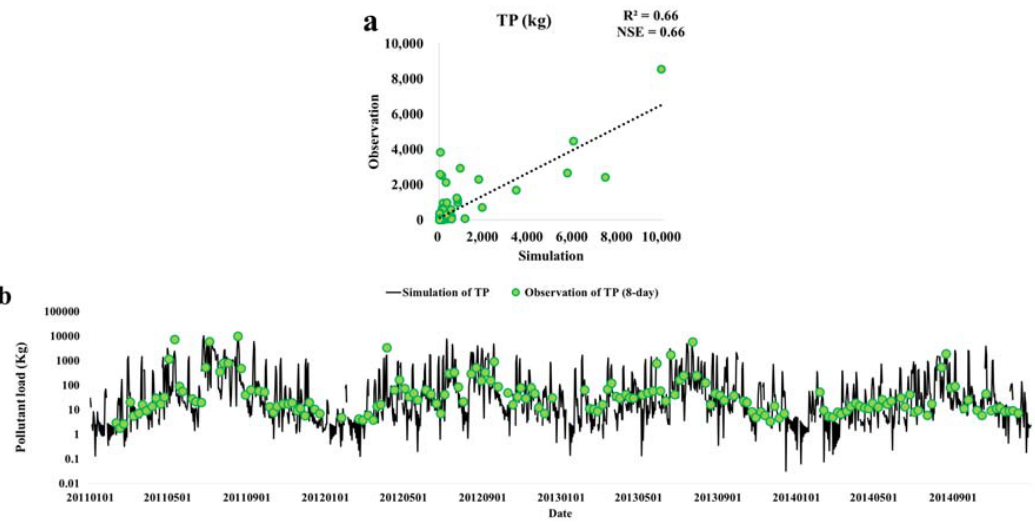
Figure 8. Comparison between simulated and observed TP at Dalcheon A watershed (2011–2014).